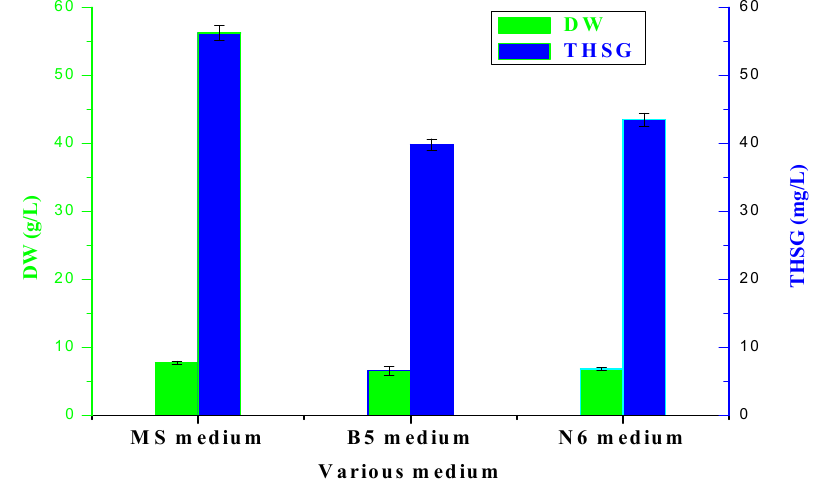
Figure 3. Effect of various medium on cells growth and THSG production of Polygonum multiflorum Thunb. FW cells were inoculated into MS medium in 250 mL shake flasks on a rotary shaker (100 rpm). The vertical bar represents standard error of three replicates.